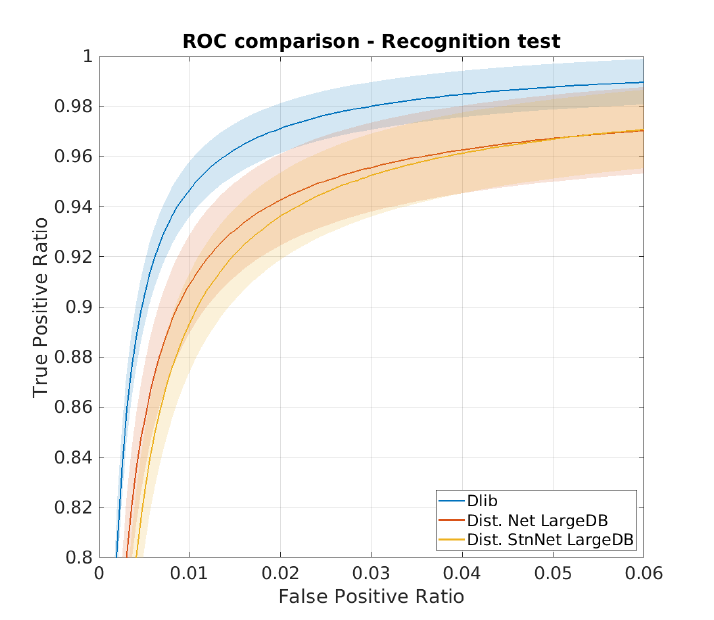
Figure 12. ROC curve comparison for the best case (30-class classifier trained with 15 samples per ID). Note that the graphs are highly zoomed portions of the entire